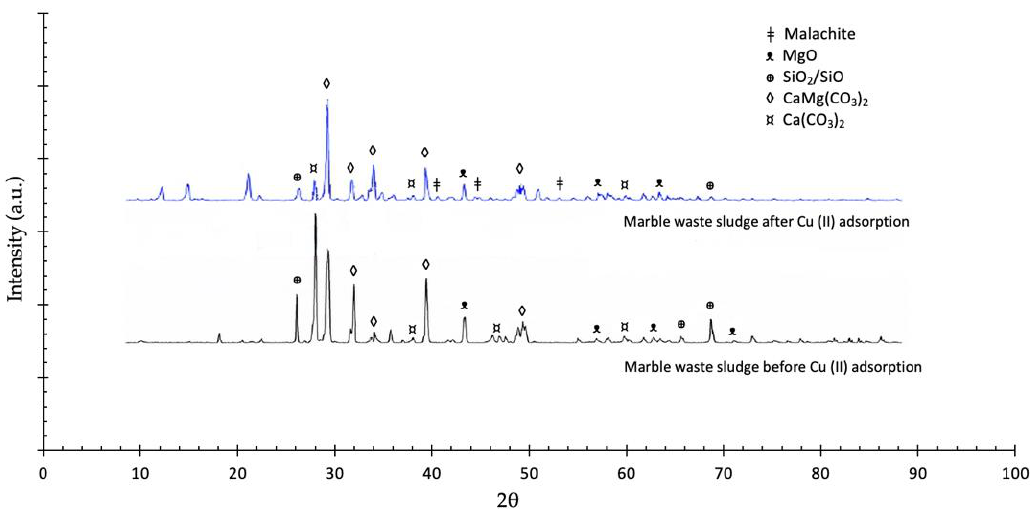
Figure 5. XRD of marble waste sludges before and after Cu (II) ion adsorption.